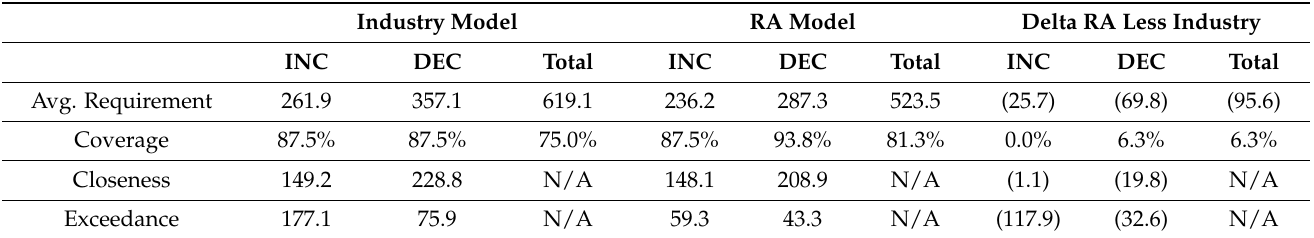
Table 12. Calculated metrics from Figure 6